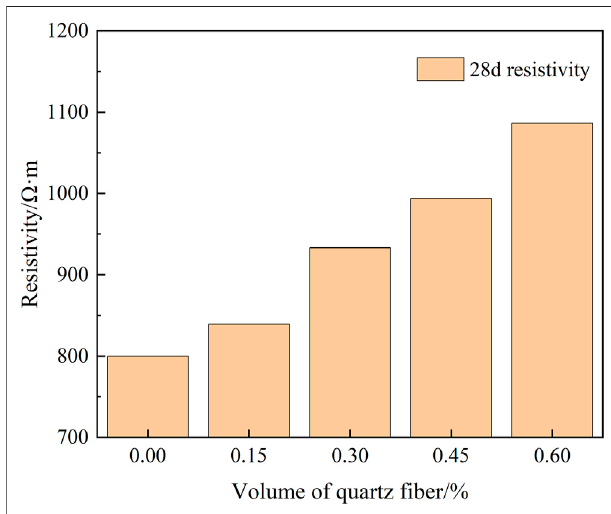
FIGURE 3 | Resistivity of high-alumina cement with different fi ber